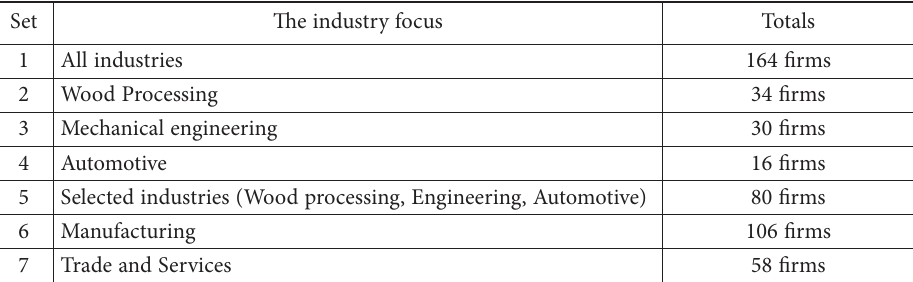
Table 1. Basic data on the data sets analyzed ( source :